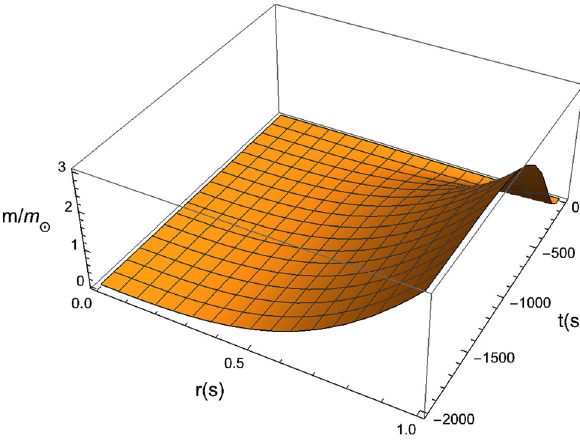
Fig. 1 Mass radial-temporal profile